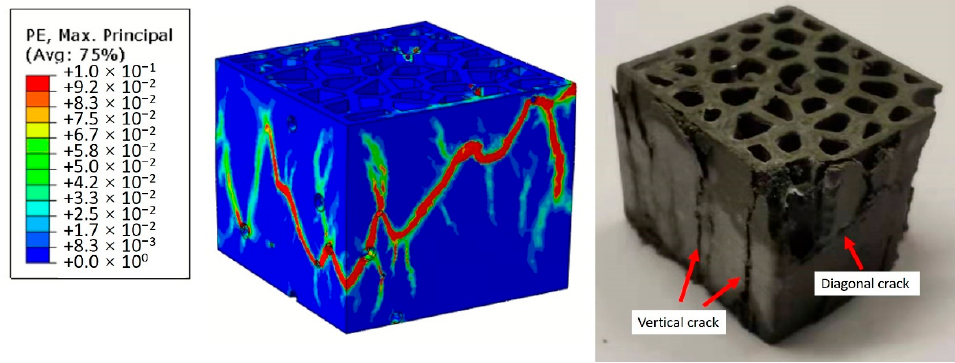
Figure 20. Comparison of the crack pattern obtained from simulated and experimental tested specimens, obtained from R7-PCM14.